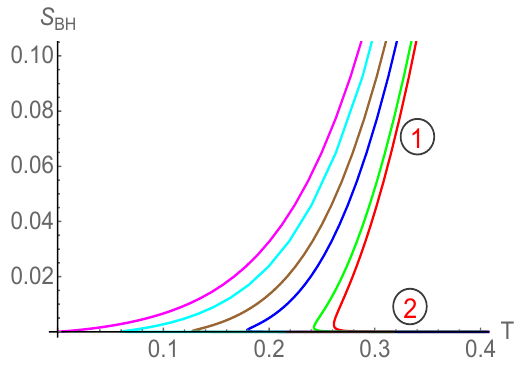
Figure 1 . S BH as a function of T for various values of (cid:22) . Here red, green, blue, brown, cyan and magenta curves correspond to (cid:22) = 0, 0 : 2, 0 : 4, 0 : 5, 0 : 6 and 0 : 673 respectively. In units GeV.